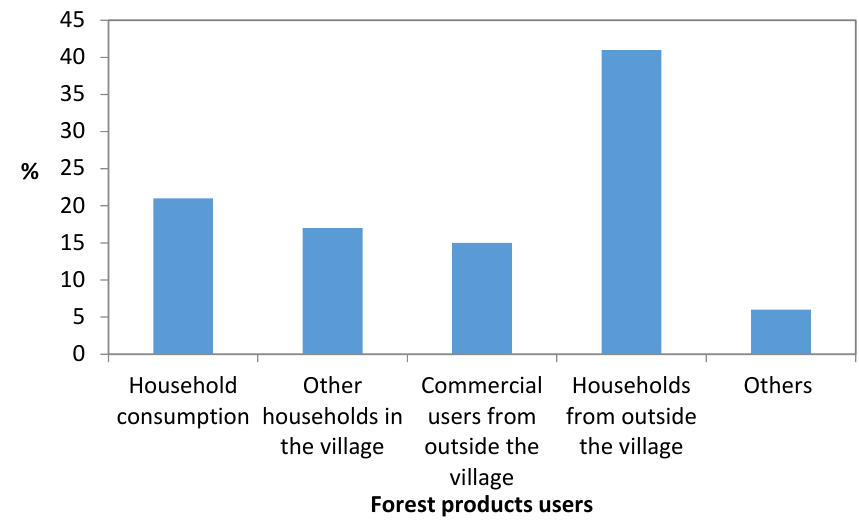
Figure 5. Main forest users in Con Cuong District, Nghe An Province, 2016.